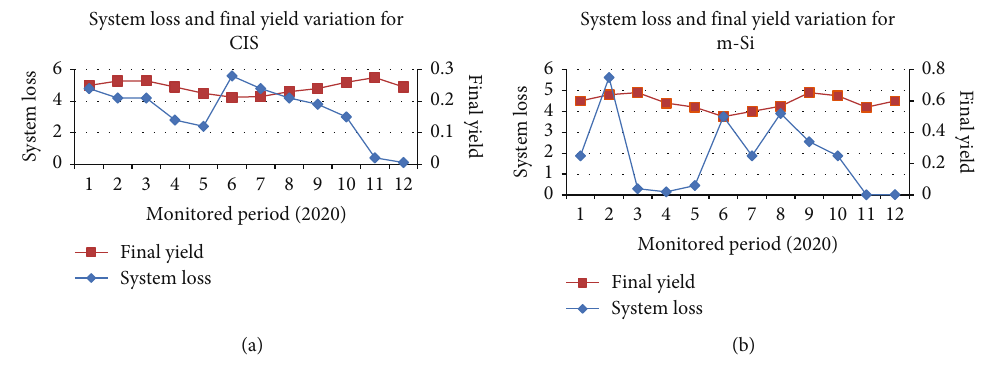
Figure 7: Final yield and system loss of (a) CIS and (b) m-Si.